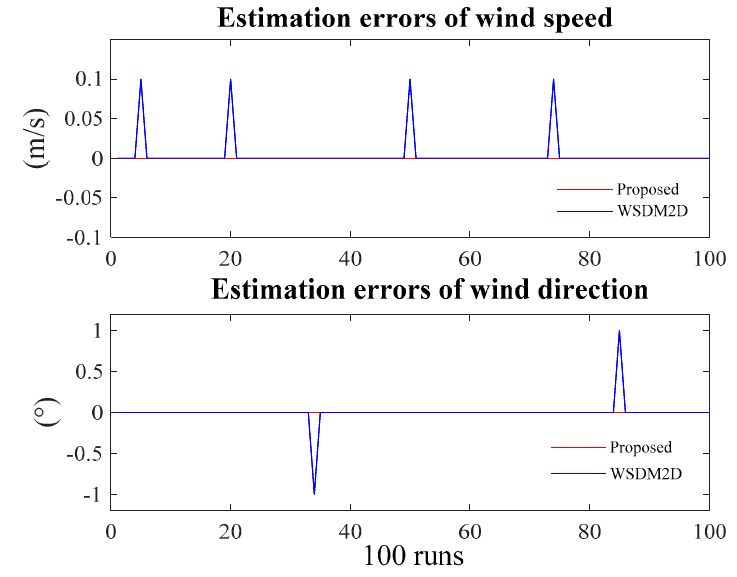
Figure 8. Estimation errors of wind speed and direction based on two methods at SNR of 5 dB.